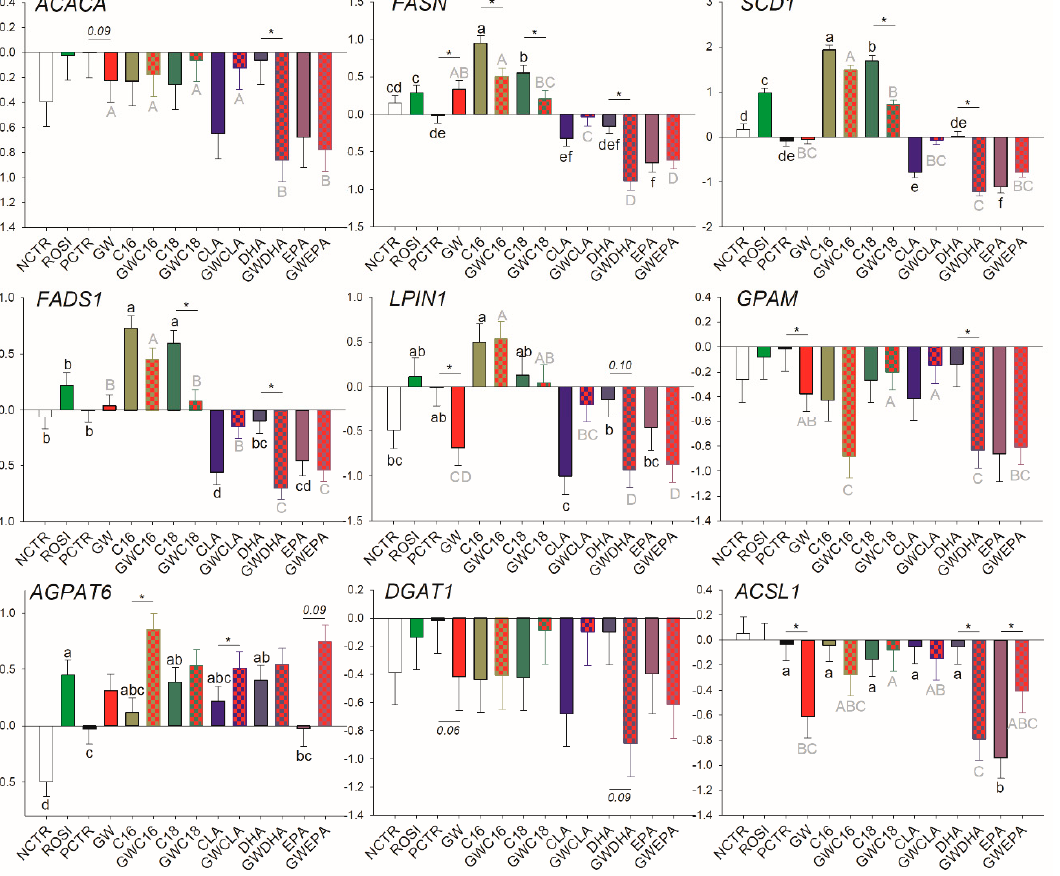
Figure 1. E ff ect of long-chain fatty acids (LCFA; palmitic acid [C16], stearic acid [C18], trans10, cis12 conjugated linoleic acid [CLA], docosahexaenoic acid [DHA], and eicosapentaenoic acid [EPA]), peroxisome proliferator-activated receptor gamma (PPAR γ ) agonist (ROSI; rosiglitazone) and LCFA + PPAR γ antagonist (GW; GW9662) on transcription of genes related to fatty acid synthesis and desaturation and triglycerides synthesis. Lower case letters and uppercase letters denote statistical differences ( p < 0.05) between treatments without GW and treatments with GW, respectively. * denotes statistical difference ( p < 0.05) between presence and absence of GW in the same LCFA treatment. For GW treatment alone, * denotes statistical difference ( p < 0.05) with the PCTR.